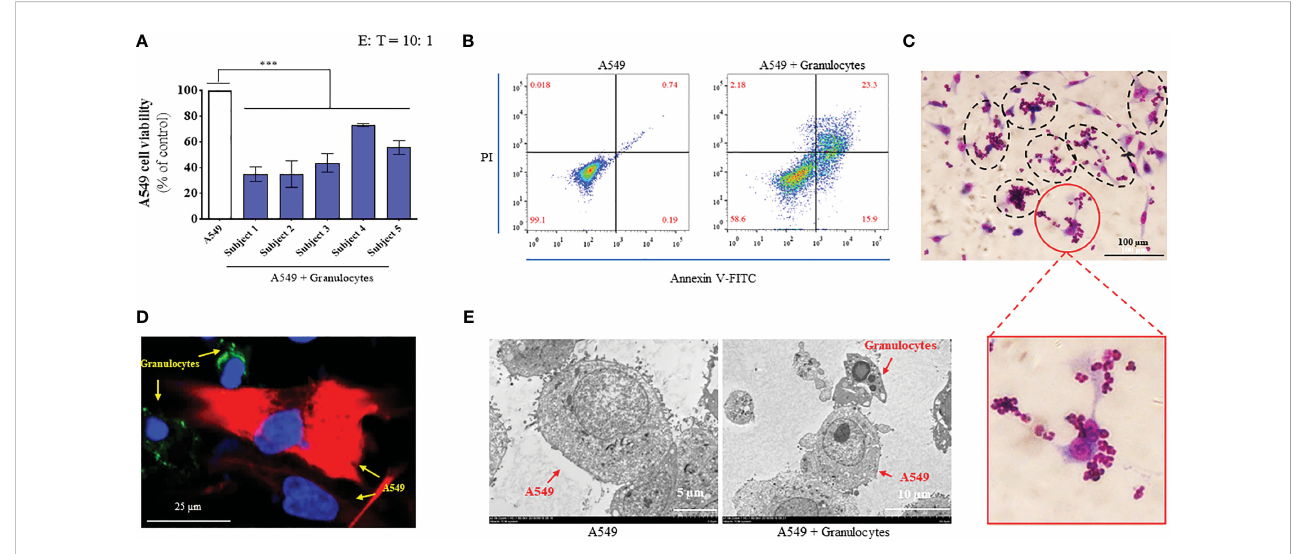
FIGURE 1 Granulocytes collected from the peripheral blood of healthy humans exhibited signi fi cant anticancer function. (A) Cancer-killing activity of granulocytes from 5 healthy volunteers tested using cell counting kit-8 (CCK-8) reagent (n = 3; mean ± SD; one-way analysis of variance with Dunnett post-test; ***, P < 0.001). (B) Cancer-killing ef fi ciency of human granulocytes against A549 tested by fl ow cytometry (Annexin V-FITC/PI). (C) Images of granulocytes attacking A549 by diff-quik staining (magni fi cation: 20 ×). (D) Confocal microscope image of granulocytes attacking A549 (magni fi cation: 60 ×). Here, A549 cells were marked by CK19 (red), granulocyte cells were marked by CD66 (green), and the nuclei were marked by DAPI (blue). (E) Transmission electron microscopy (TEM) images of A549 (left, magni fi cation: 2000 ×) and granulocyte attacking A549 (right, magni fi cation: 1500